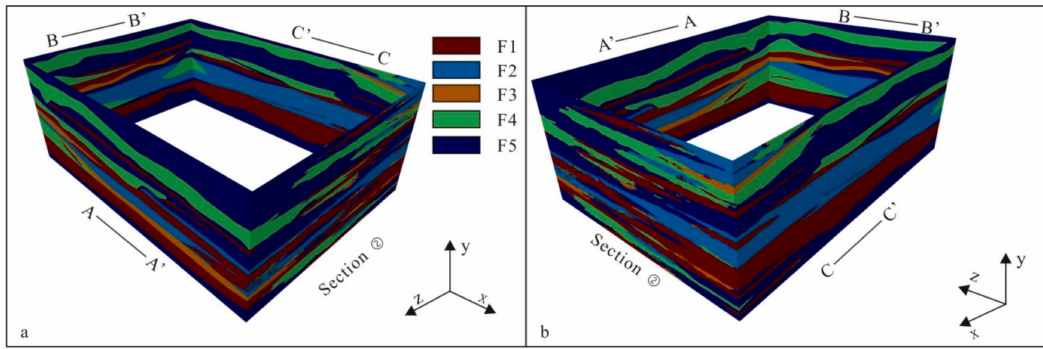
Figure 8. Simulated results of section (2) under the conditioning data relocation with anisotropic multiple grids (( a , b ) are di ff erent point of view of the simulation results of section